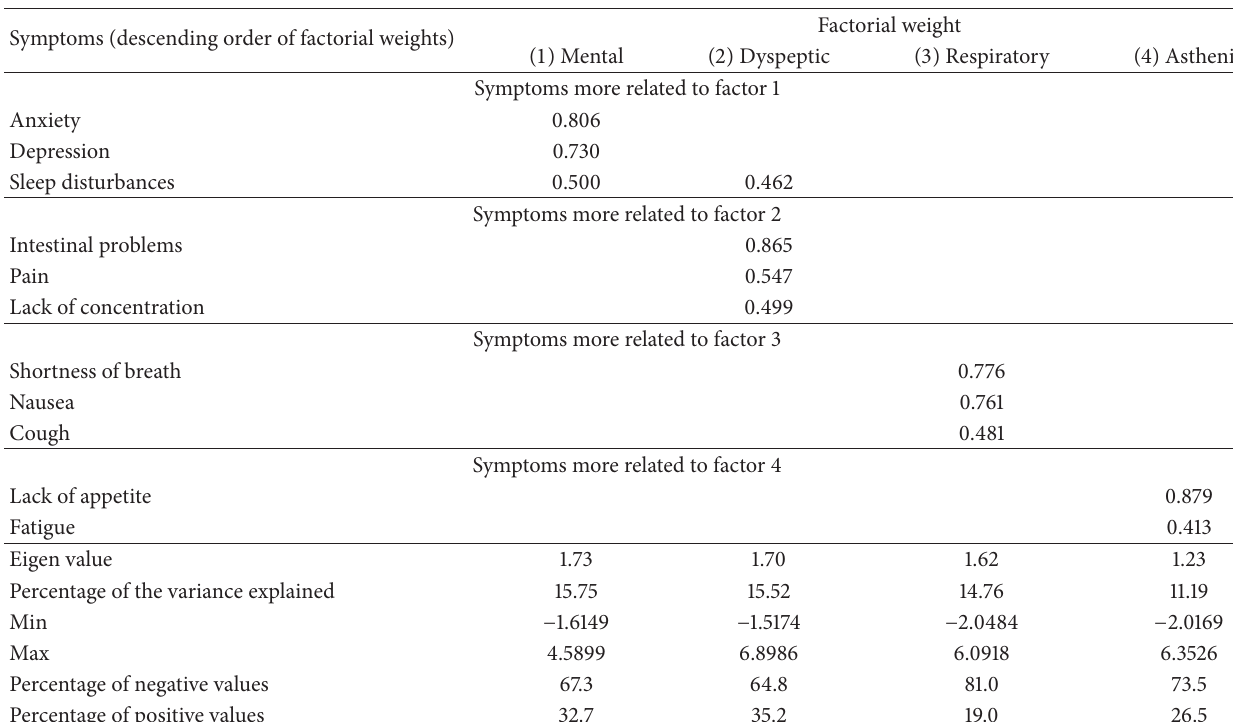
Table 4: Factorial distribution of seafarers’ distress symptoms before